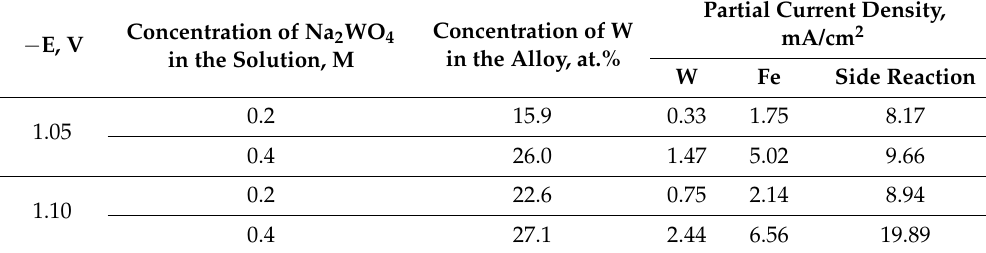
Table 3. Dependence of concentration of tungsten in the Fe-W coatings (at.%) and partial current densities on the concentration of Na 2 WO 4 in the electrolyte and applied cathodic potential (deposition time ~1